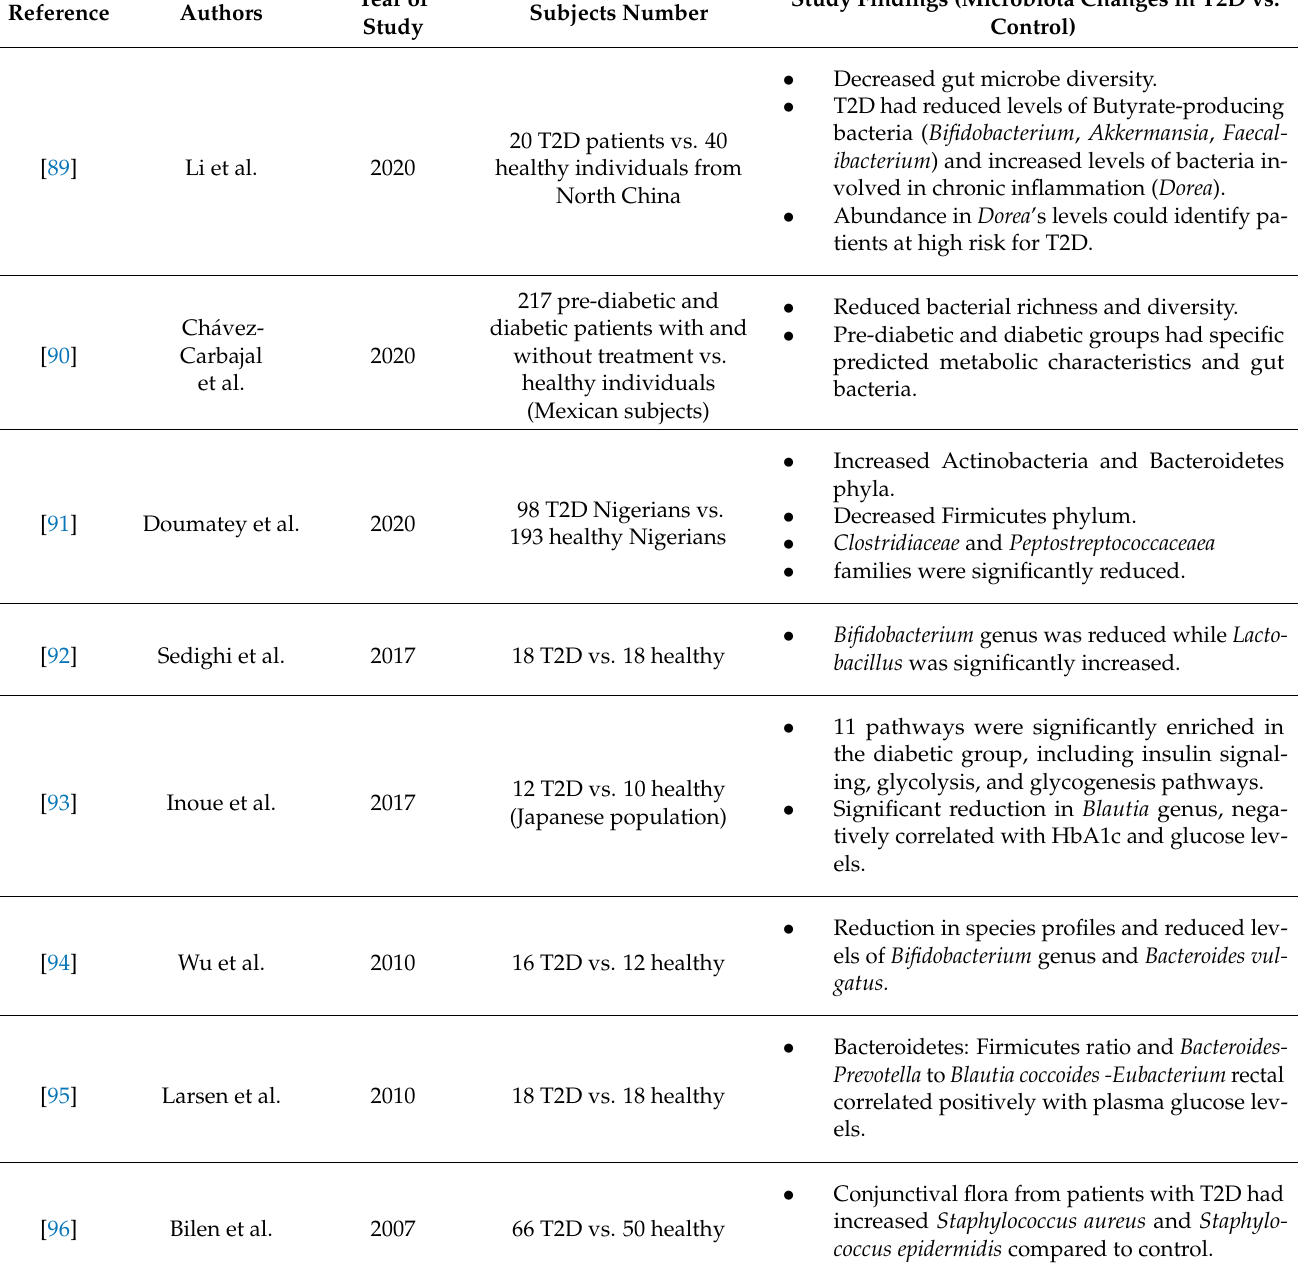
Table 4. Human studies of the gut microbiota in